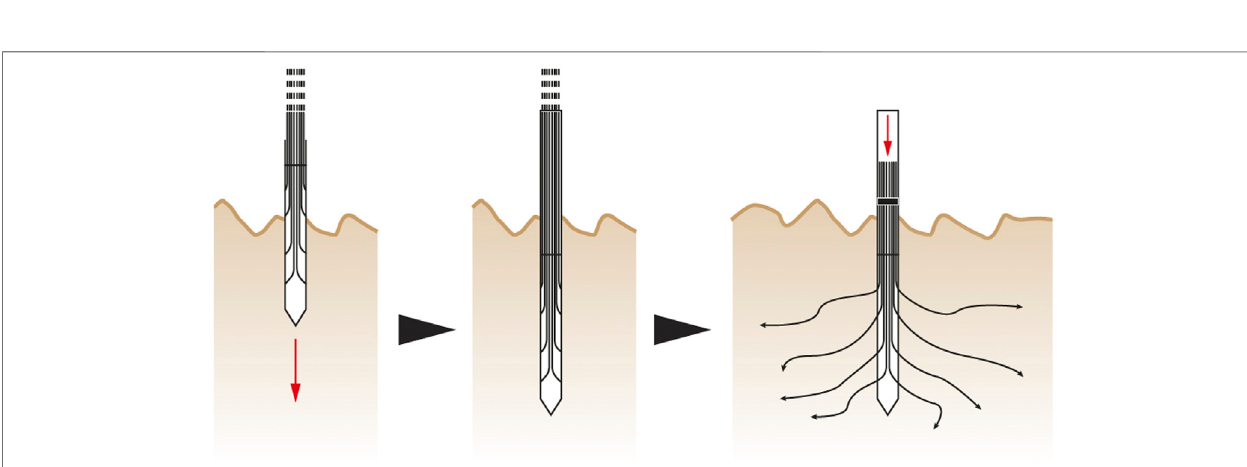
FIGURE 5 | Hierarchical foundation concept — First, the smooth vertical pile is driven in the soil (left) . Once the pile is in place, individual semi- fl exible elements are laterally pushed into the soil (right) .